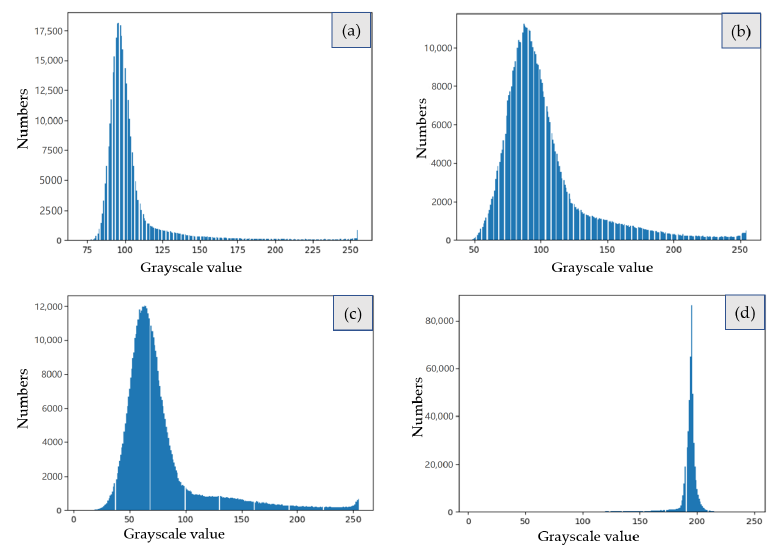
Figure 9. Defect image histogram: ( a ) initial image; ( b ) histogram equalization; ( c ) MSR; ( d ) this article’s algorithm.